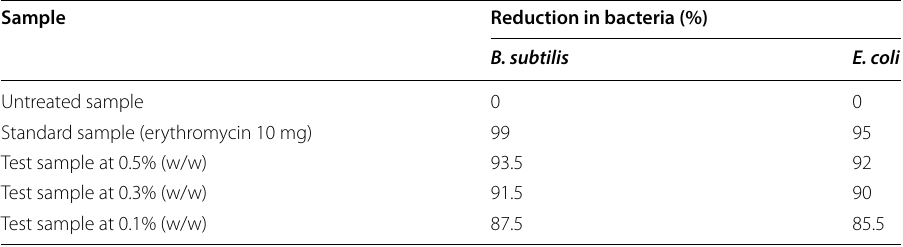
Table 5 Percent reduction in bacteria of untreated, standard and treated sample Sample